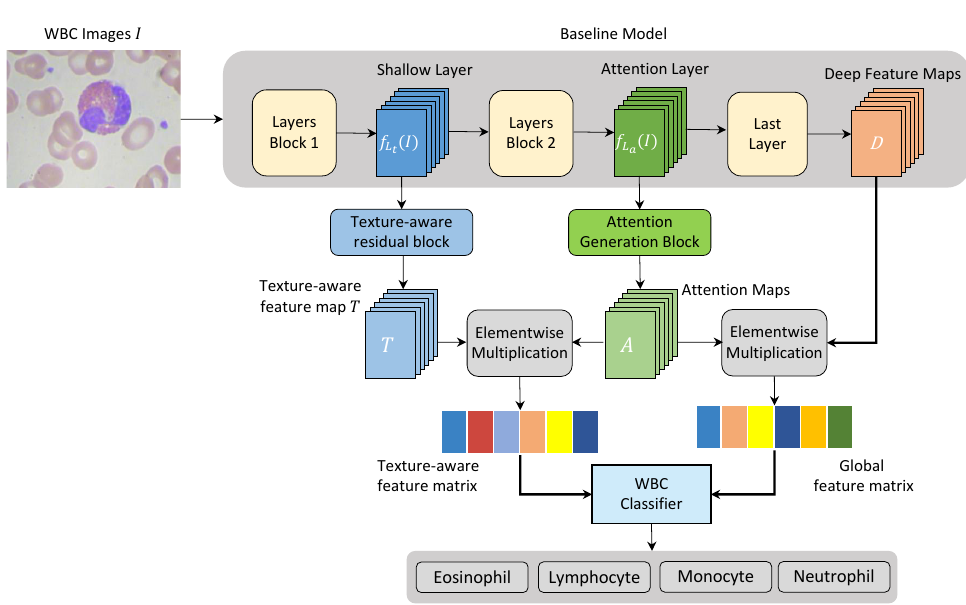
Figure 2. Overall framework of the proposed attention-based white blood cell classification ap- proach. It is composed of three main components, including texture-aware residual block, attention generation, and attention-based data augmentation through element-wise multiplication and nor- malized average pooling. The presented framework is generalizable to different backbone